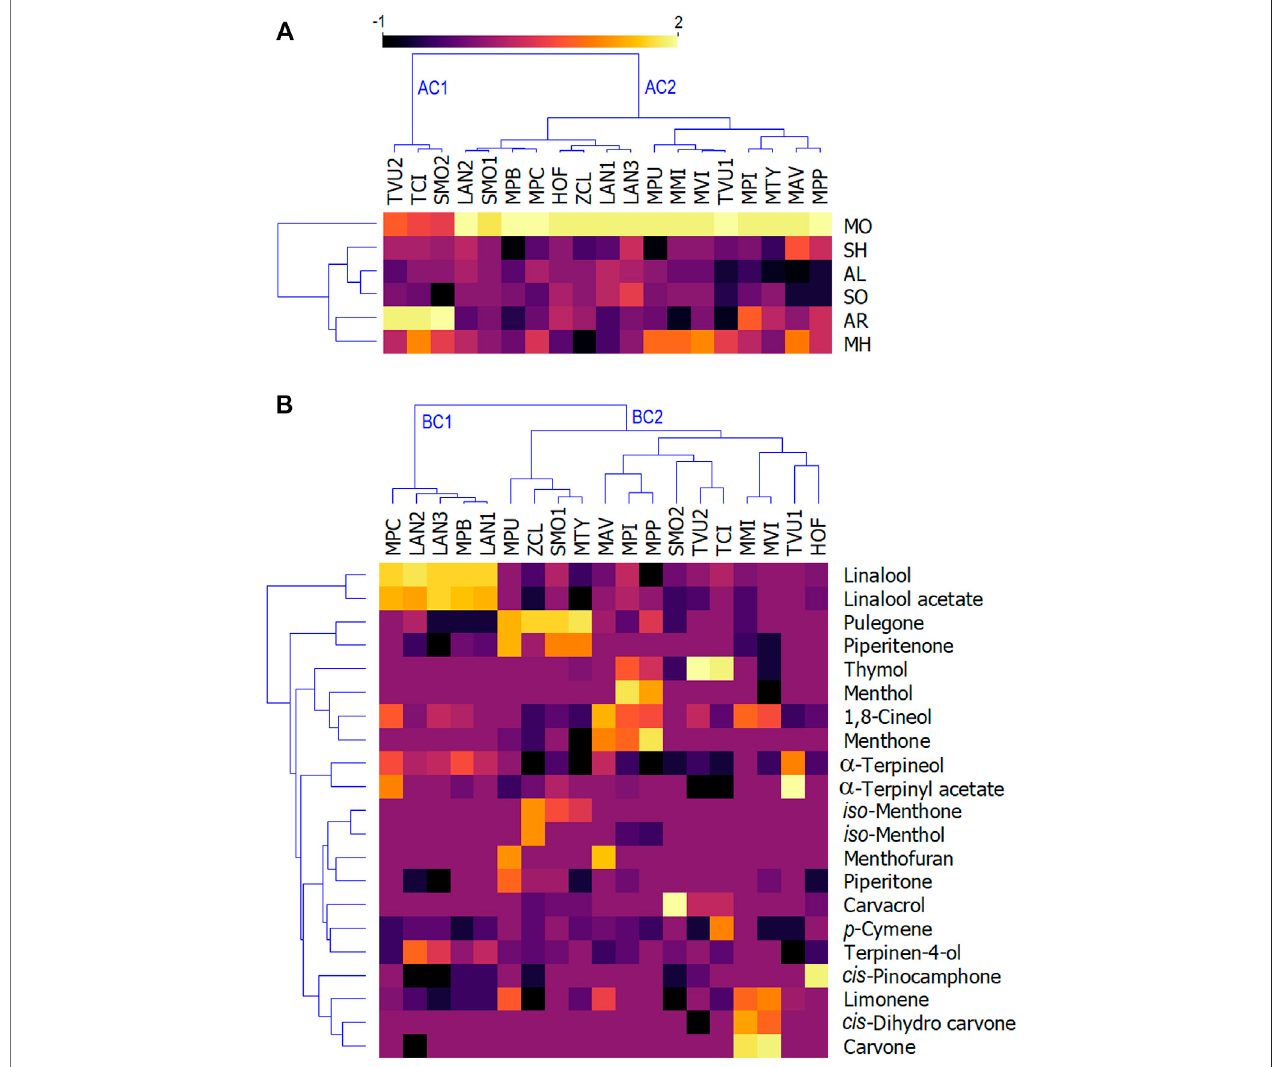
FIGURE 2 | Heatmaps of the levels of volatile compounds in investigated essential oils. (A) classes of essential oil volatiles; (B) the most abundant terpenes in the oils. MAV — Mentha aquatica “ Veronica ” ; MPU — Mentha pulegium ; MMI — Mentha microphylla ; MVI — Mentha vilosa ; MPI — Mentha x piperita ; MPB — Mentha x piperita “ Bergamot ” ; MPP — Mentha x piperita “ Perpeta ” ; MPC — Mentha x piperita “ Citrata ” ; TVU1 — Thymus vulgaris 1; TVU2 — Thymus vulgaris 2 ; TCI — Thumys x citriodorus ; LAN1 — Lavandula augustifolia 1; LAN2 — Lavandula augustifolia 2; LAN3 — Lavandula augustifolia 3; SMO1 — Satureja montana 1; SMO2 — Satureja montana 2; MTY — Micromeria thymifolia ; HOF — Hyssopus of fi cinalis ; ZCL — Ziziphora clinopodioides; MH — monoterpene hydrocarbons; MO — oxygenated monoterpenes; SH — sesquiterpene hydrocarbons; SO — oxygenated sesquiterpenes; AL — aliphatic compounds; AR — aromatic compounds.